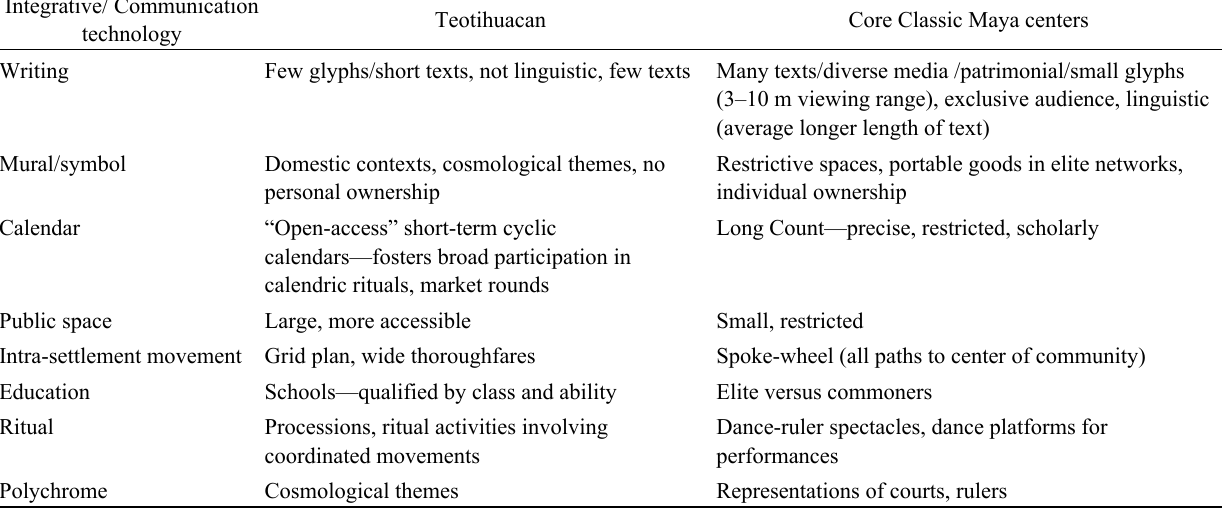
Table 5 Differences between Teotihuacan and Classic